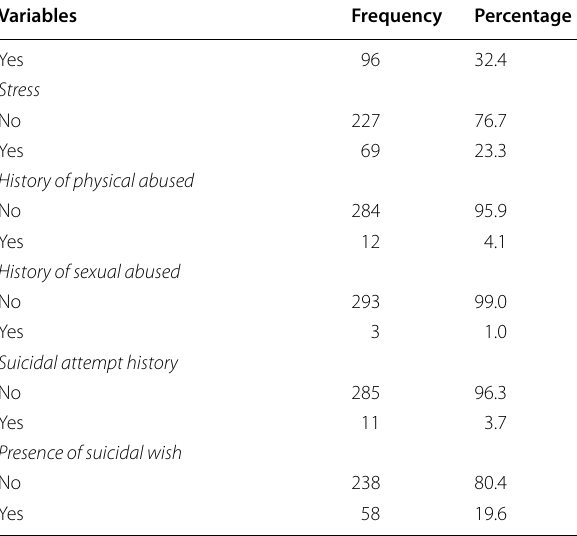
Table 2 Distribution of study subjects by clinically related factors of peoples with epilepsy ( n 296) on follow-up at Ayder = comprehensive specialized hospital and Mekelle hospital,